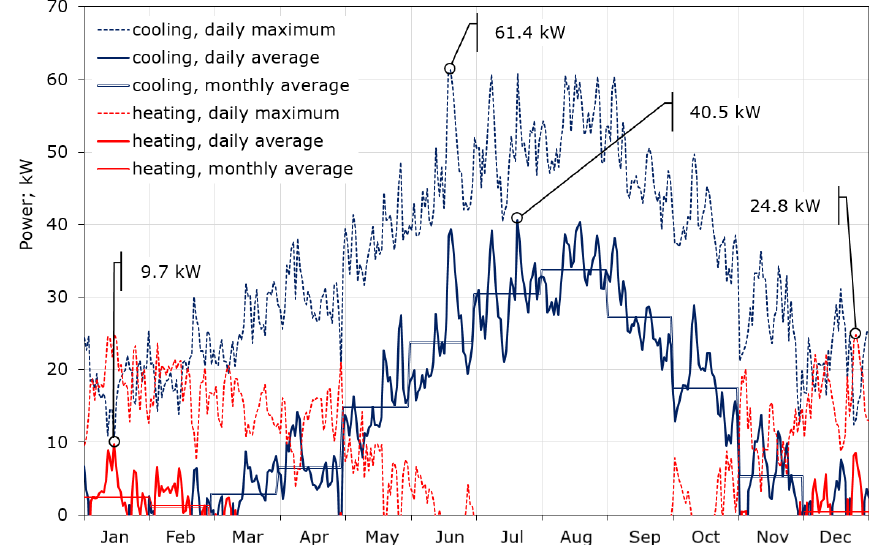
Figure 7. Required cooling and heating power of the CIESOL building throughout the year; calculations based on TMY data for Almeria, Spain.